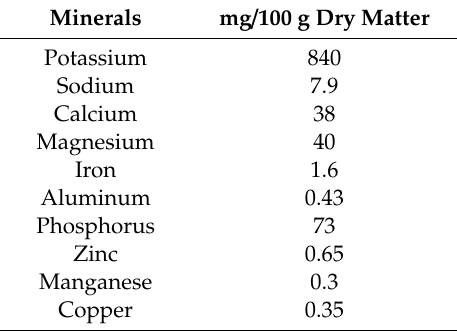
Table 5. Mineral contents in apple